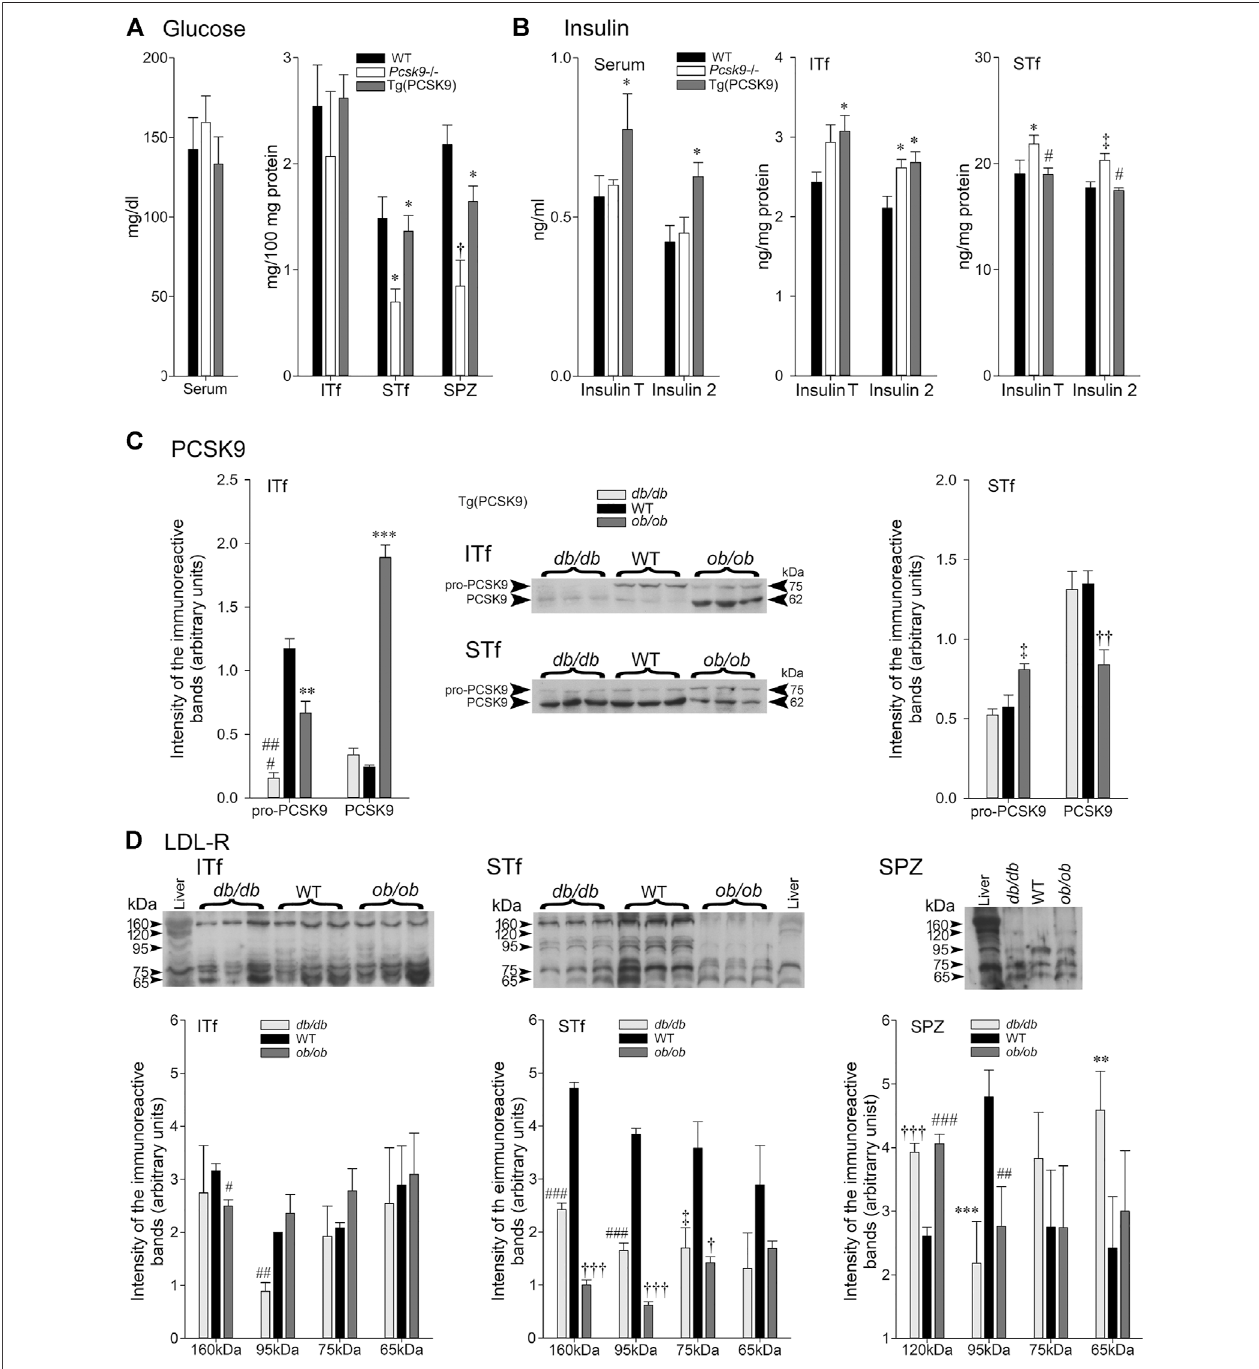
FIGURE 5 | (A) Glucose and (B) Insulin in Pcsk9 − / − and Tg (PCSK9) mice; (C) PCSK9 and (D) LDL-R in db/db and ob/ob mice. (A) Glucose: Serum : glucose concentrations are not signi fi cantly different in Pcsk9 − / − and Tg (PCSK9) mice compared to WT. In ITf, glucose concentrations are not different in Pcsk9 − / − , Tg (PCSK9) and WT mice. In STf, glucose levels drop signi fi cantly in Pcsk9 − / − mice (* p < 0.05 vs. WT) but recover in Tg (PCSK9) mice (* p < 0.05 vs. Pcsk9 − / − mice). Glucose concentrations signi fi cantly decrease in Pcsk9 − / − mouse spermatozoa ( † p < 0.01 vs. WT mice) but recover in Tg (PCSK9) mice (* p < 0.05 vs. Pcsk9 − / − ). (B) Insulin: Serum insulinT and insulin2 levels mice are signi fi cantly higher in Tg (PCSK9) compared to Pcsk9 − / − mice and WT (* p < 0.05). ITf: InsulinT signi fi cantly increase in Tg (PCSK9) mice (* p < 0.05 vs. WT mice). The upsurge in insulin2 is signi fi cant in Pcsk9 − / − and Tg (PCSK9) mice (* p < 0.05 vs. WT). STf: insulinT in Pcsk 9 − / − signi fi cantly increases (* p < 0.05 vs. WT mice); the WT InsulinT values recover in Tg (PCSK9) mice ( # p < 0.02). Insulin2 in Pcsk9 − / − mice signi fi cantly increase ( ‡ p < 0.03 vs. WT mice) butrecoversWTlevelsinTg(PCSK9)mice( # p < 0.02vs. Pcsk9 − / − mice).Thevaluesarethemean±SEM; n =3animalsperexperimentalgroup. (C) PCSK9in db/db and ob/ob mice. Representative immunoblots with corresponding histograms of pro-PCSK9 and PCSK9 protein levels in ITf and STf. ITf: pro-PCSK9 levels are signi fi cantly